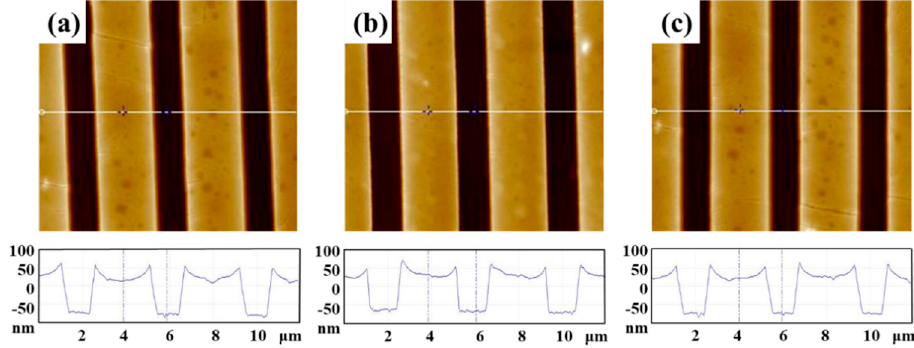
Figure 3. AFM images of PMMA/Ti 4+ lines obtained with different contact time: ( a ) 5 s, ( b ) 60 s and ( c ) 180 s.